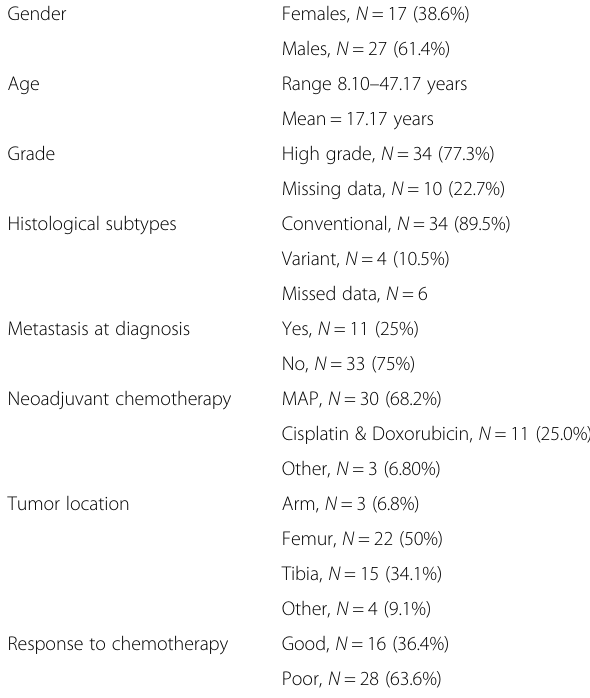
Table 2 Patient ’ s demographics and clinical characteristics